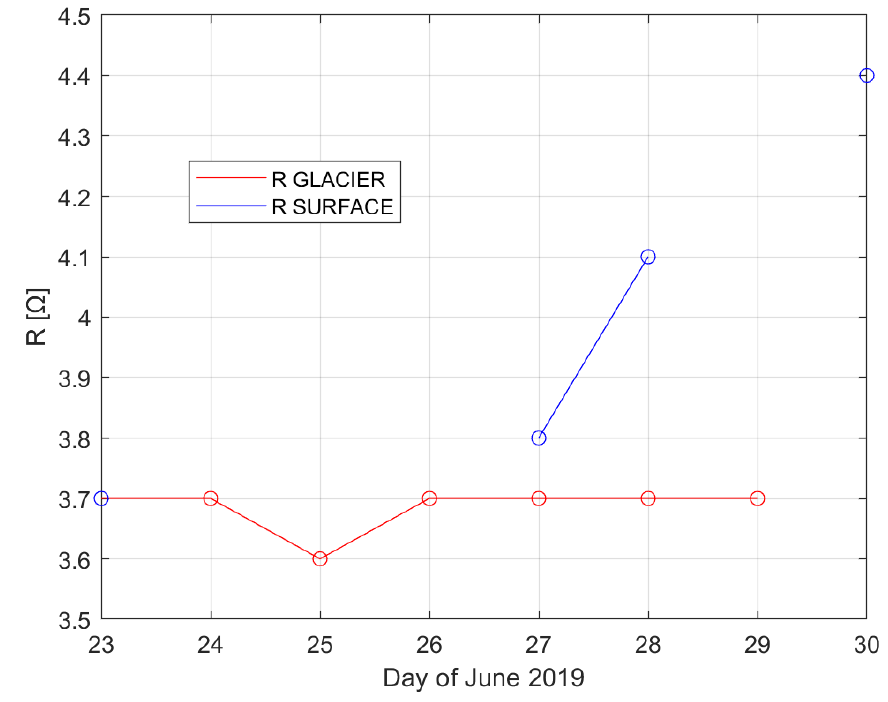
Figure 5. The measured DC resistances of the antennas.